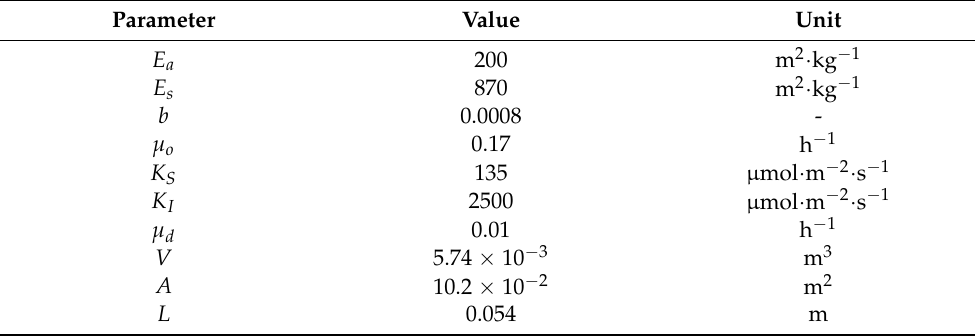
Table 1. The parameters of the photosynthetic growth model